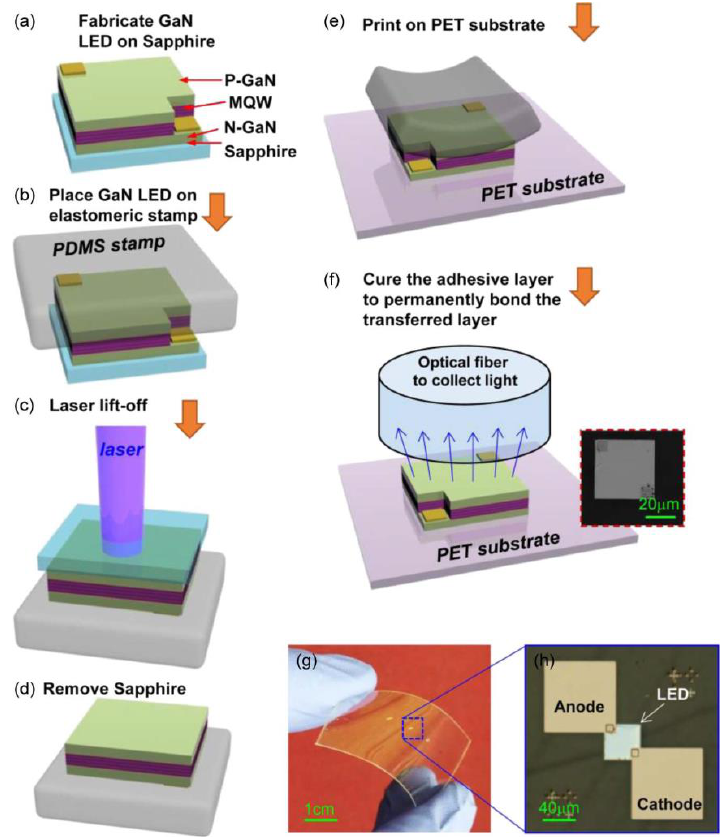
Figure 8. Schematic of the fabrication process for GaN LEDs on a PET substrate using a laser lift-off (LLO) and transfer-printing method. ( a ) Fabrication of GaN LEDs on a sapphire substrate. ( b ) Place